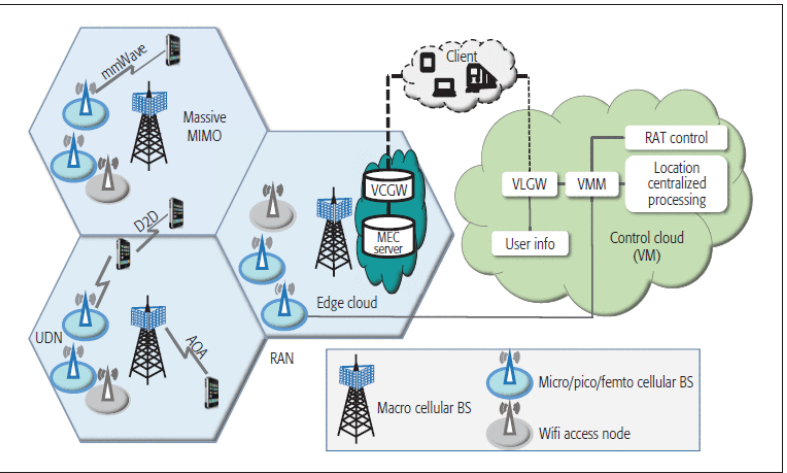
Figure 1. An example for a 5G positioning architecture